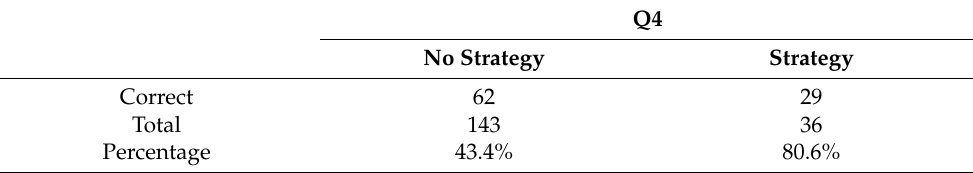
Table 8. Correct responses percentage, according to strategy or not in Q4.